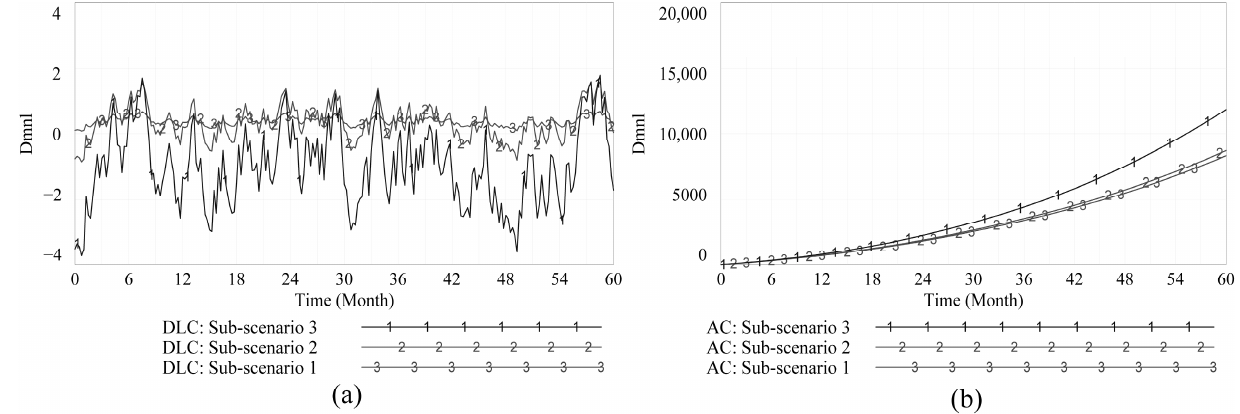
Figure 6. Evolution of DLC and AC under the enterprise performance scenarios. Subfigures ( a , b ) illustrate the DLC and AC curves under varied sub-scenarios. Table 6. Enterprise network relationship scenario setting.